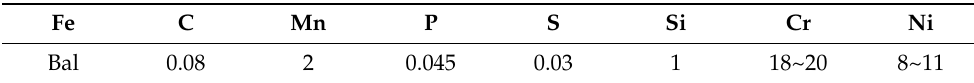
Table 2. Chemical composition of 304 stainless steel (wt.%) [25].